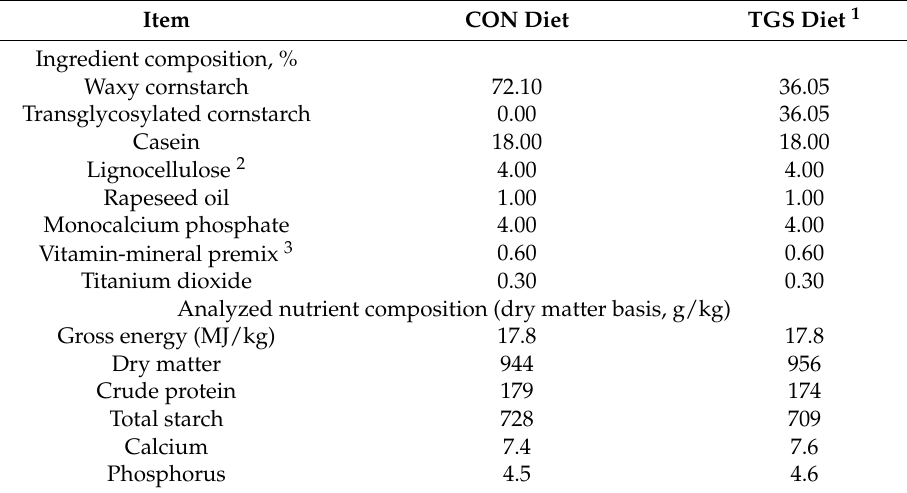
Table 1. Ingredient and analyzed nutrient composition of experimental